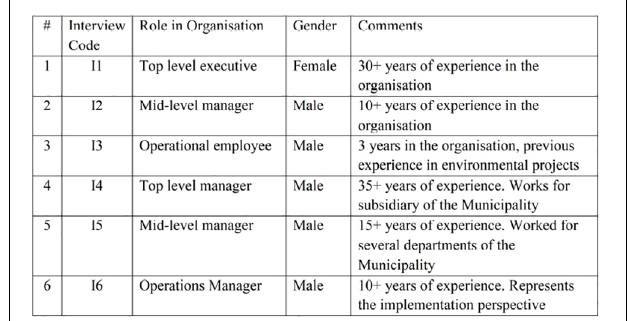
FIGURE 1 | A summary of interview characteristics.